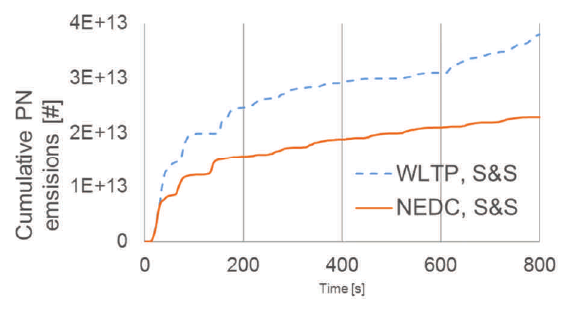
Fig. 3. Cumulative PN emissions (solid particles only) from vehicle 1